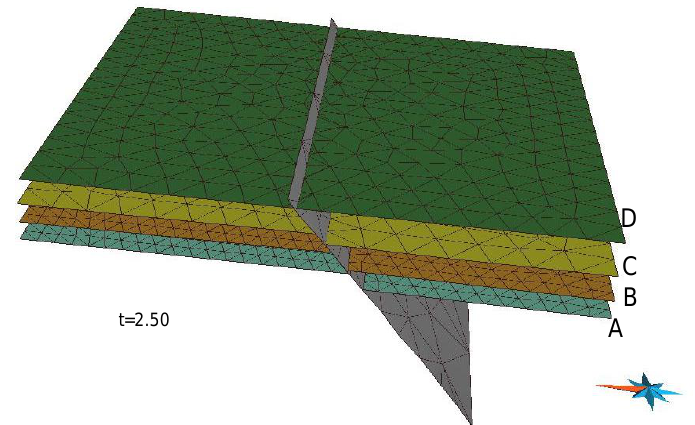
Figure 12. The geological structure of an area of interest at time t = 2.50